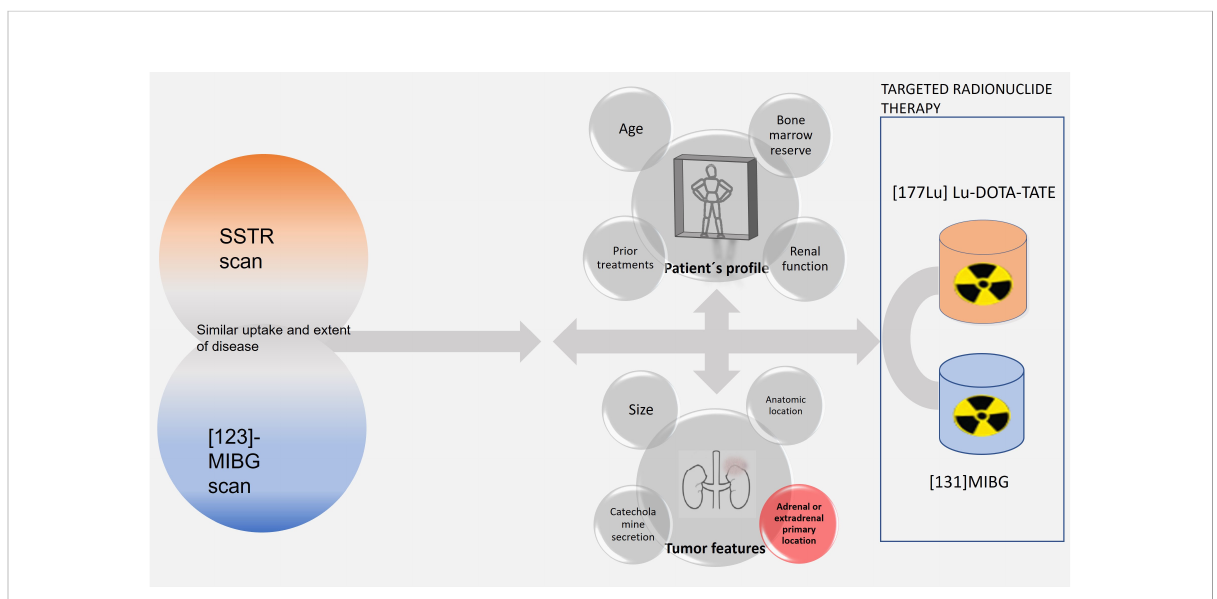
FIGURE 5 Flow chart of functional imaging fi ndings, patient pro fi le, and tumor features involved in the selection of